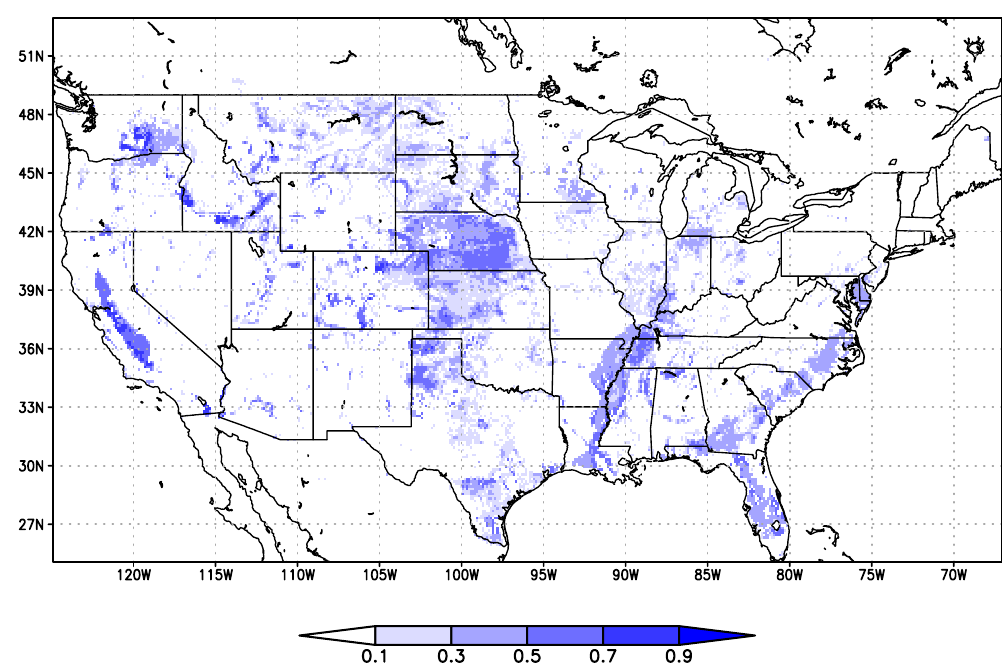
Figure 4. Kolmogorov–Smirnov distance ( D ) from comparison of soil moisture distributions from SIM1 and SIM2